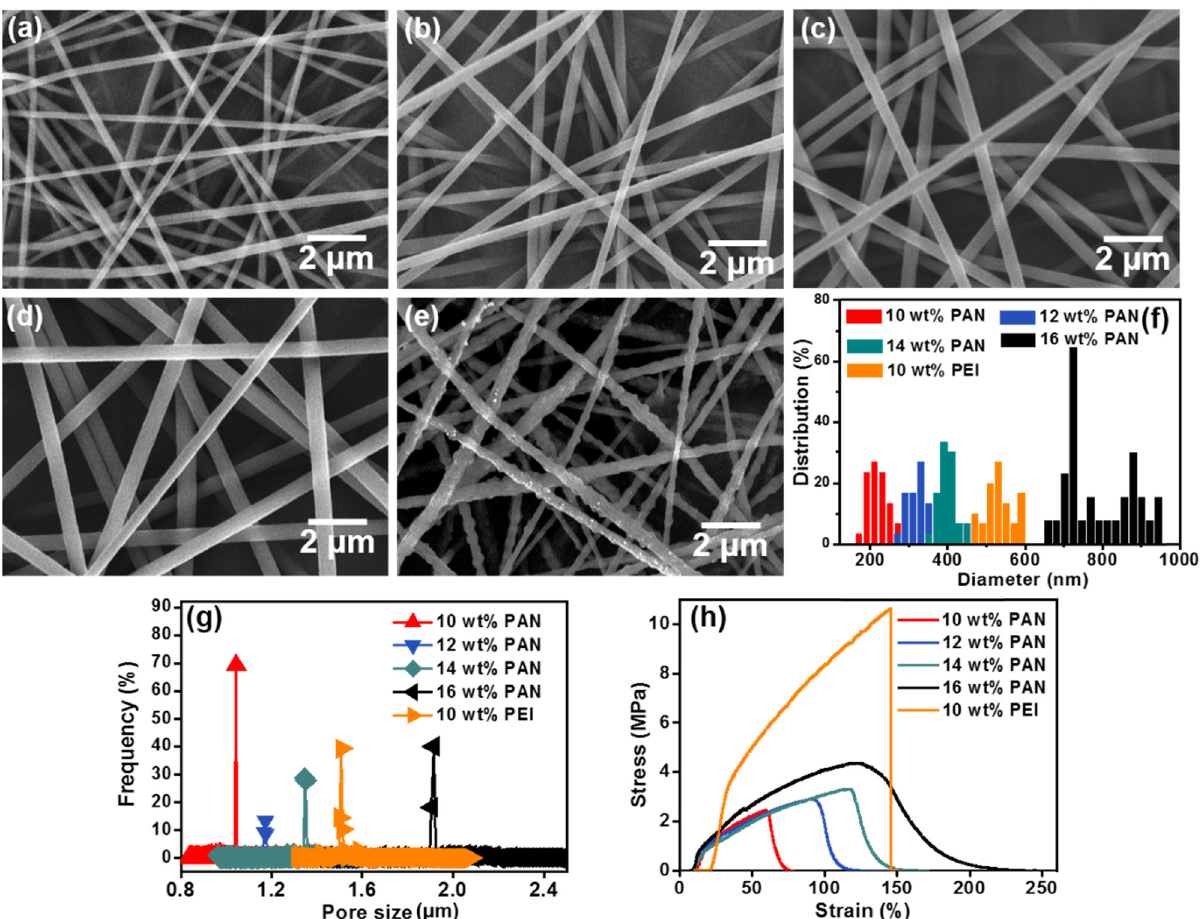
Figure 2: SEM images of PAN membranes obtained from various concentrations ( a ) – ( d ) and PEI fi brous membrane ( e ) . Fiber diameter distribution ( f ) , PSD ( g ) , and stress – strain curves ( h ) of the relevant